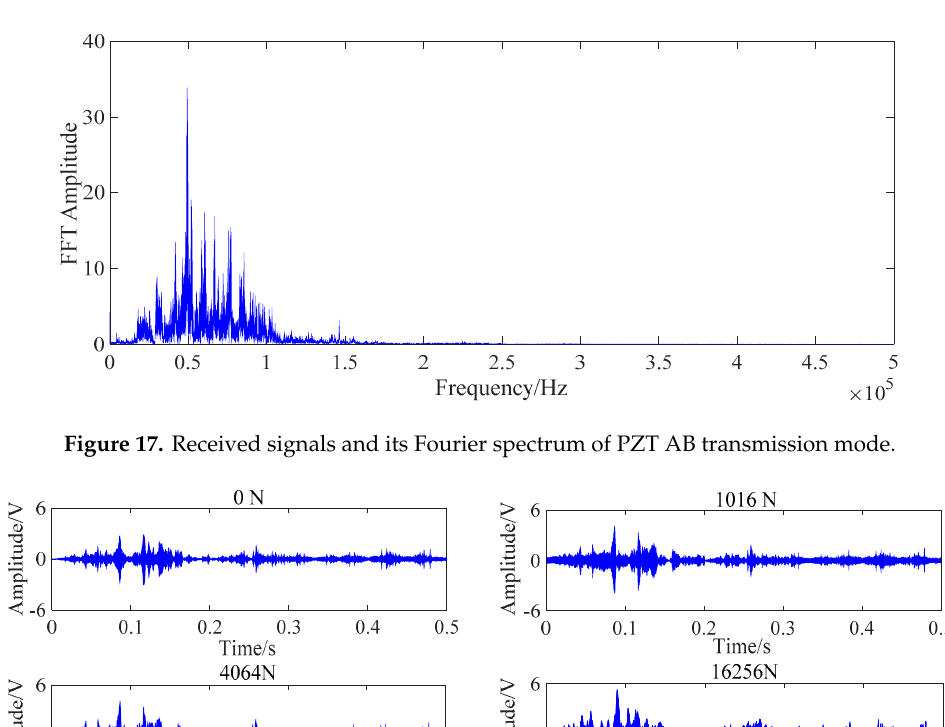
Figure 17. Received signals and its Fourier spectrum of PZT AB transmission mode.